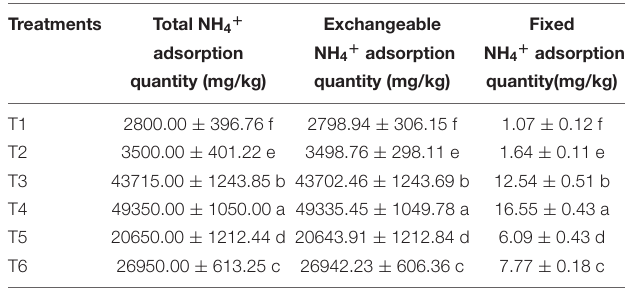
three replicates ± SE. Different letters indicate significant differences at P <